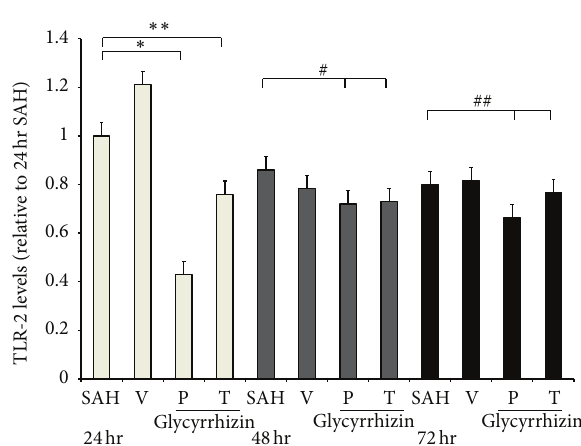
Figure 3: Expression of tissue Toll-like receptor 2 (TLR-2) on 24 hr, 48 hr, and 72 hr (Western blot). SAH; (V) SAH + vehicle; (P) Precondition glycyrrhizin +SAH; (T) glycyrrhizin +SAH. ∗ , ∗∗ : 𝑃 < 0.01 , animals in P and T groups compared with the SAH group. # , ## : 𝑃 > 0.05 , compared with the animals subject to SAH 48 hr and 72 hr, respectively.